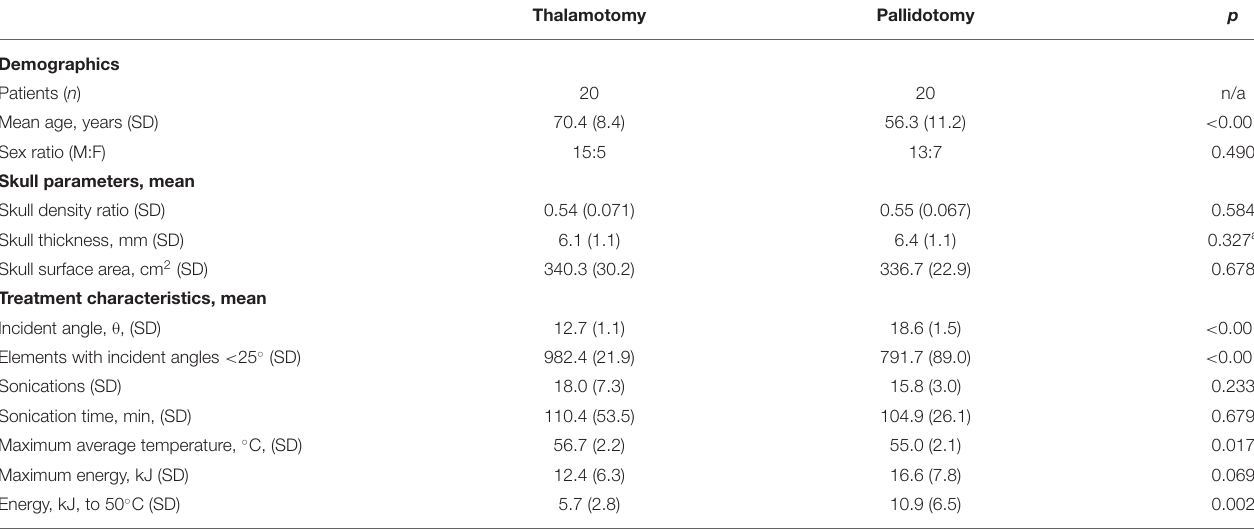
TABLE 1 | Demographics, skull parameters, and treatment characteristics of magnetic resonance-guided focused ultrasound unilateral thalamotomy and